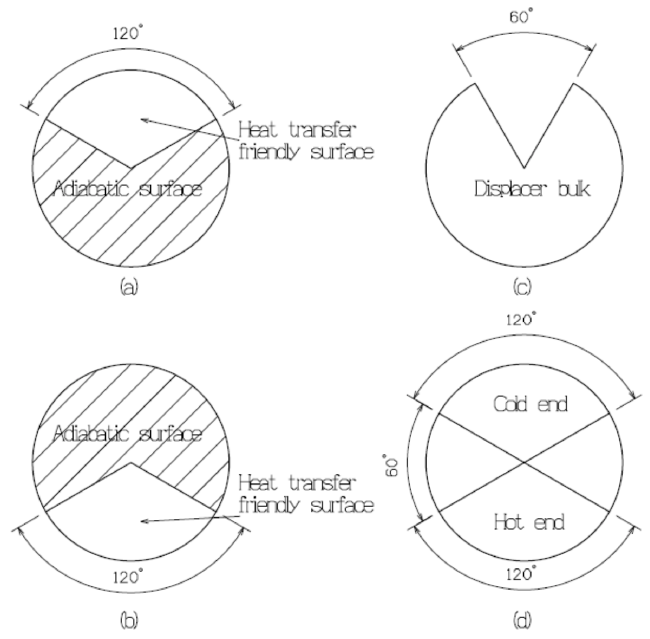
Figure 2. Displacer end plates surface sections and displacer notch: ( a ) upper end plate as the cold end; ( b ) lower end plate as the hot end; ( c ) displacer bulk with notch; ( d ) end plate phasing.